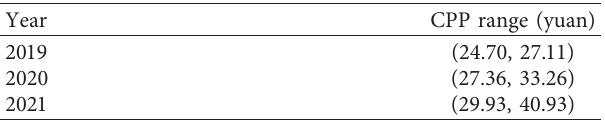
Table 16: The 2h CPP range in the core area of Ningbo city in future years